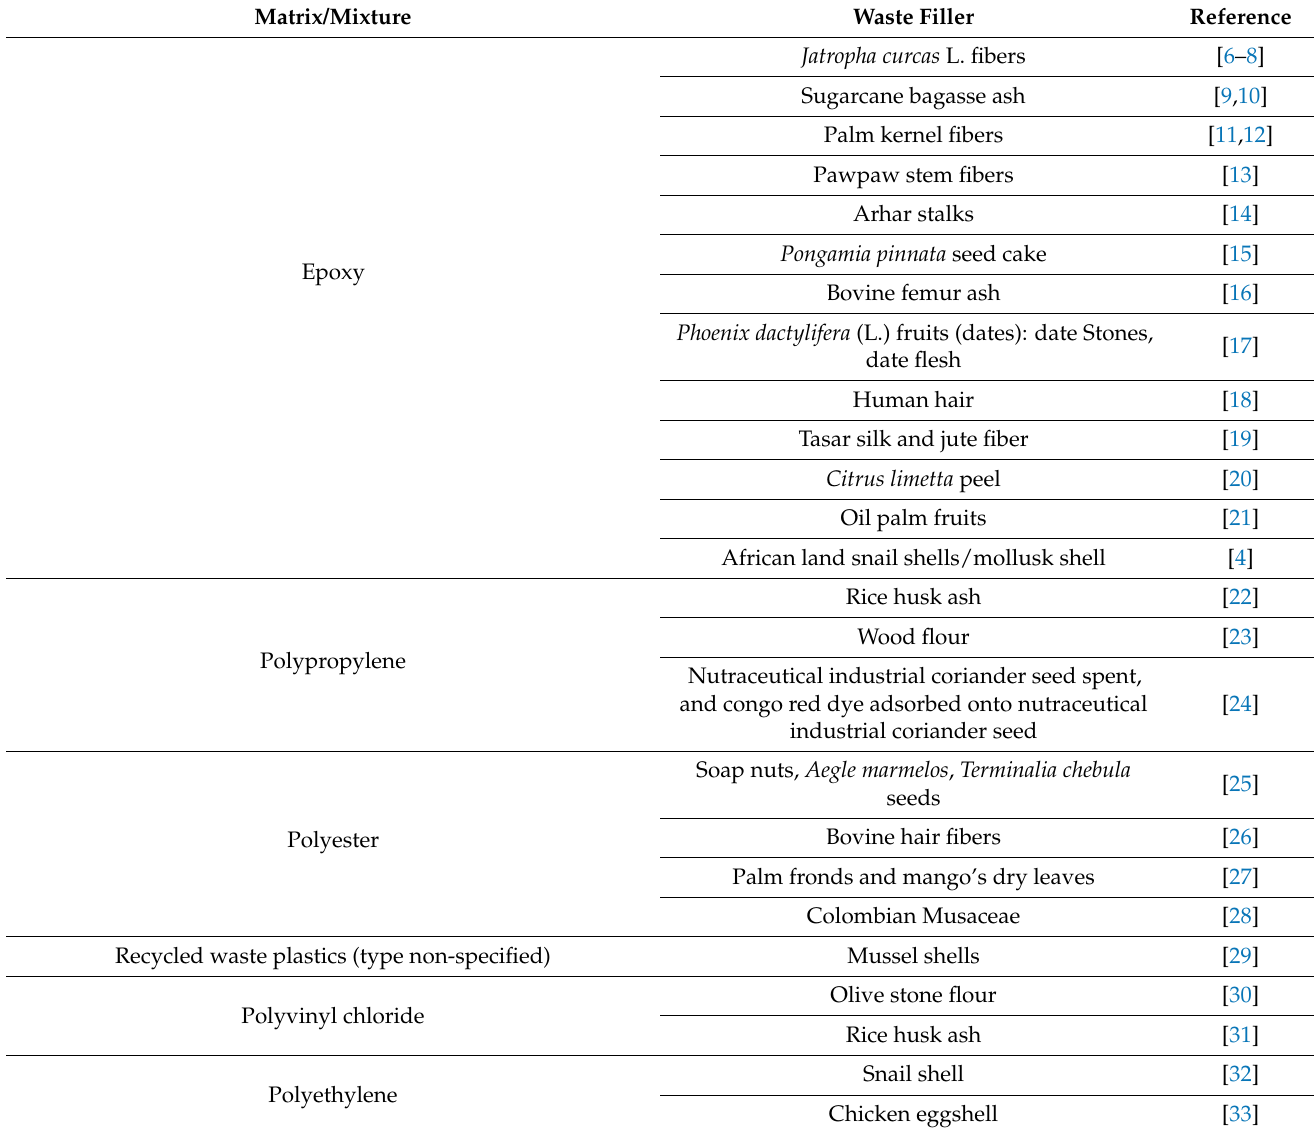
Table 1. Polymer and metal matrix composites reinforced with agricultural waste